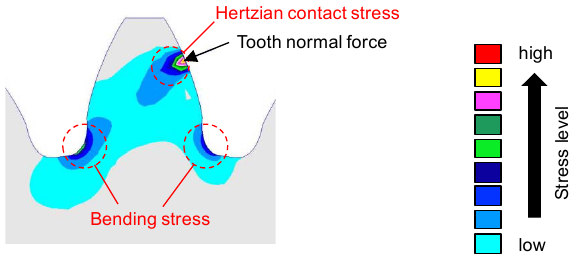
Figure 4. Schematic distribution of stress inside a gear tooth indicating highly loaded areas (Hertzian contact stress at tooth flank, bending stress at tooth root).